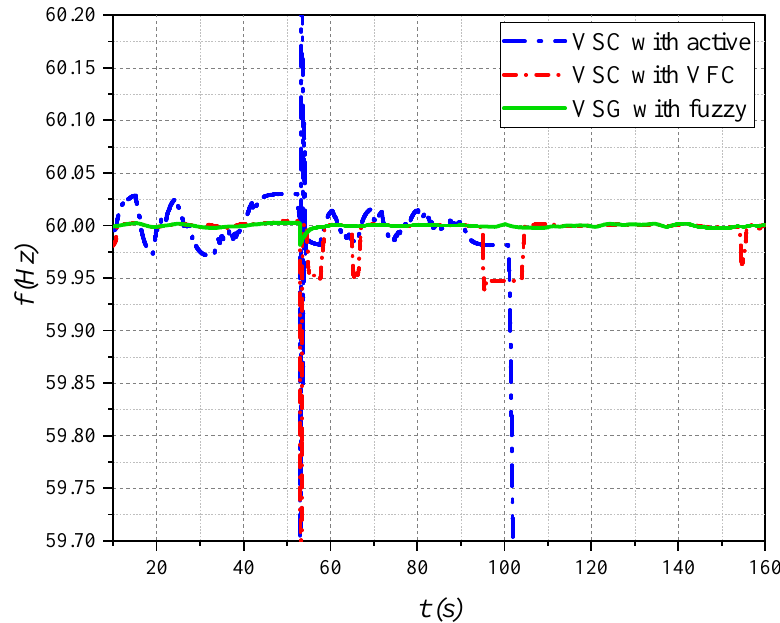
Figure 33. Microgrid frequency for the scenario presented in Section 4.3.